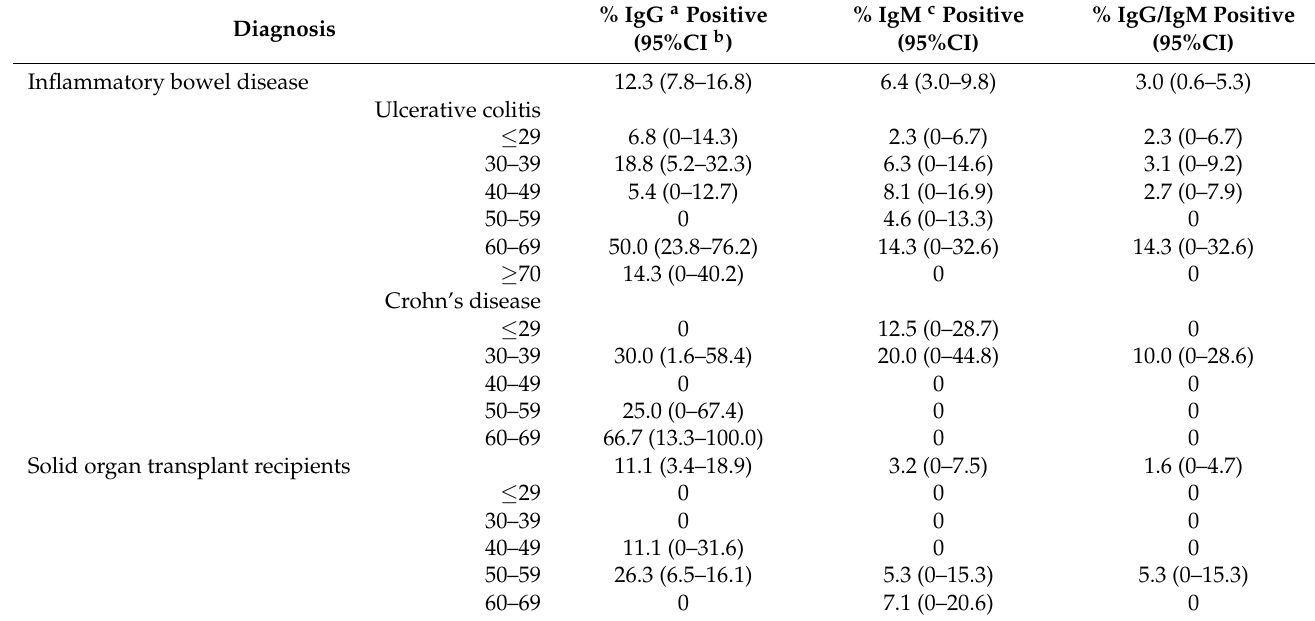
Table 3. Seroprevalence of HEV (anti-HEV IgG, IgM, and IgG/IgM) by adult characteristics and clinical condition.